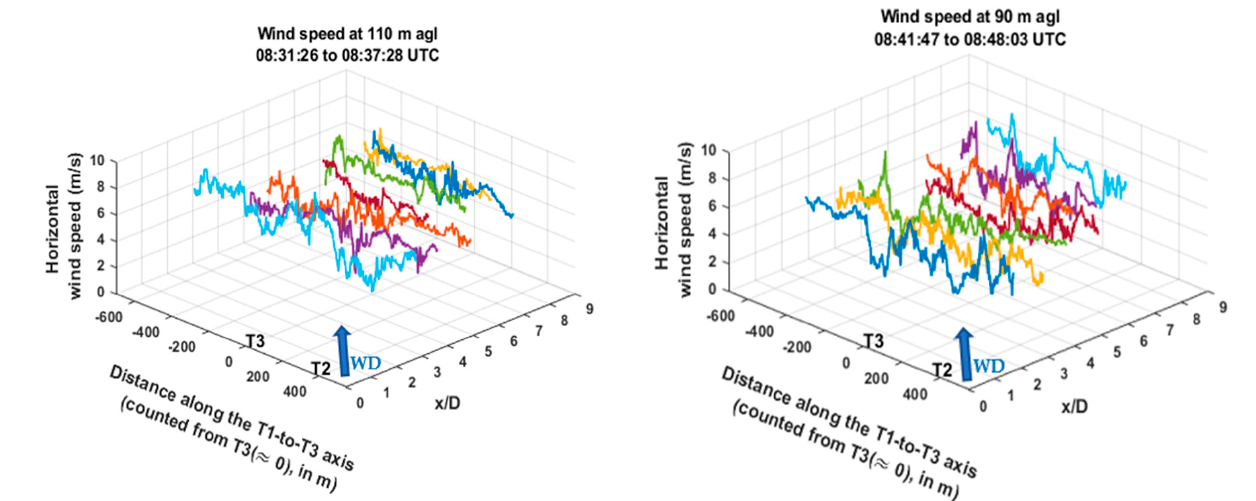
Figure 9. 3-D representation of the instantaneous horizontal wind speed measured during the flight on 28 April when BOREAL flew parallel to the T1-to-T3 axis at distinct moments and different flight altitudes. X represents the distance between the UAV and the T1-to-T3 axis normalized by the rotor diameter D (=92 m). The blue arrows indicate the average wind direction (WD). The remaining axis represents the distance (in m) to the horizontal axis perpendicular to x passing through T3.